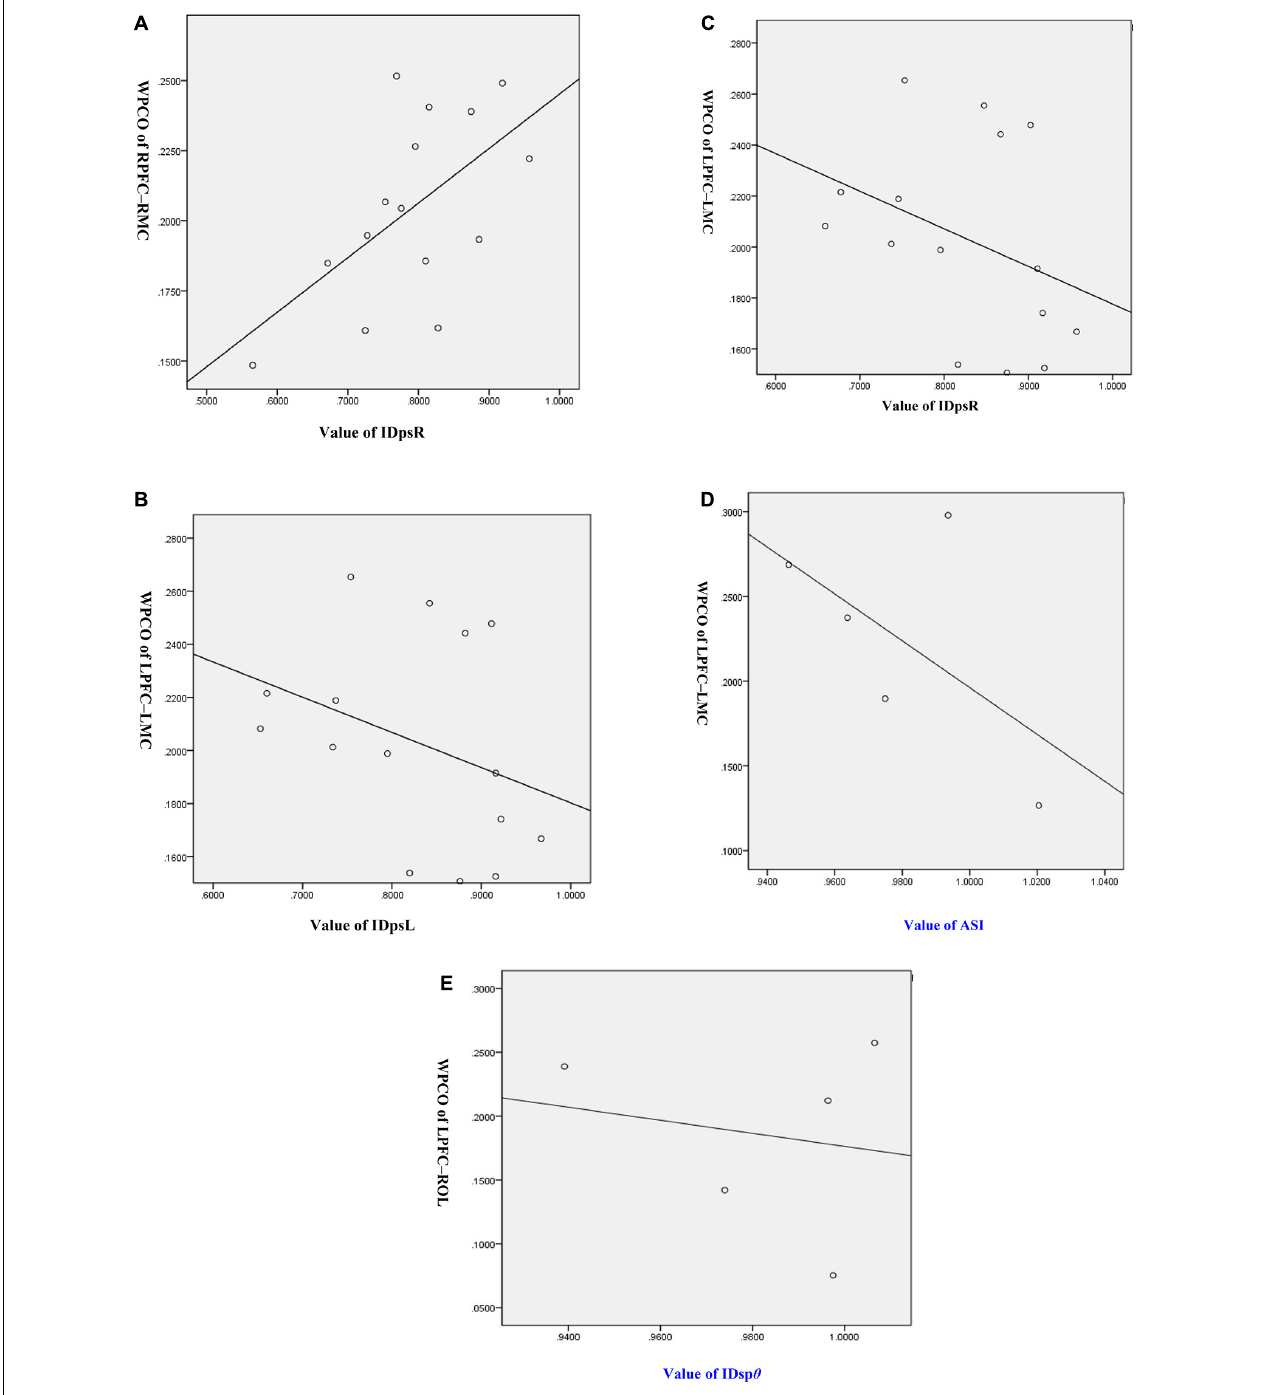
FIGURE 7 | Correlation analysis of wavelet phase coherence (WPCO) values and gait symmetry values. (A) Correlation analysis between WPCO values of RPFC-RMC and values of IDpsR. (B) Correlation analysis between WPCO values of LPFC-LMC and values of IDpsL. (C) Correlation analysis between WPCO values of LPFC-LMC and values of IDpsR. (D) Correlation analysis between WPCO values of LPFC-LMC and values of ASI. (E) Correlation analysis between WPCO values of LPFC-ROL and values of IDsp θ . IDpsL, left relative symmetry index; IDpsR, right relative symmetry index; ASI, asymmetry index; IDsp θ , the step size symmetry index in polar coordinates; RPFC, right prefrontal cortex; LPFC, left prefrontal cortex; RMC, right motor cortex; LMC, left motor cortex; ROL, right occipital leaf cortex.